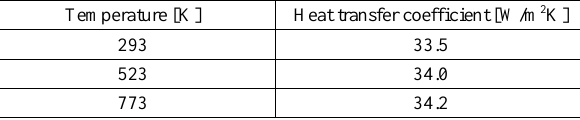
Table 5. Material properties of steel called 42CrMn04 [1] Temperature [K]